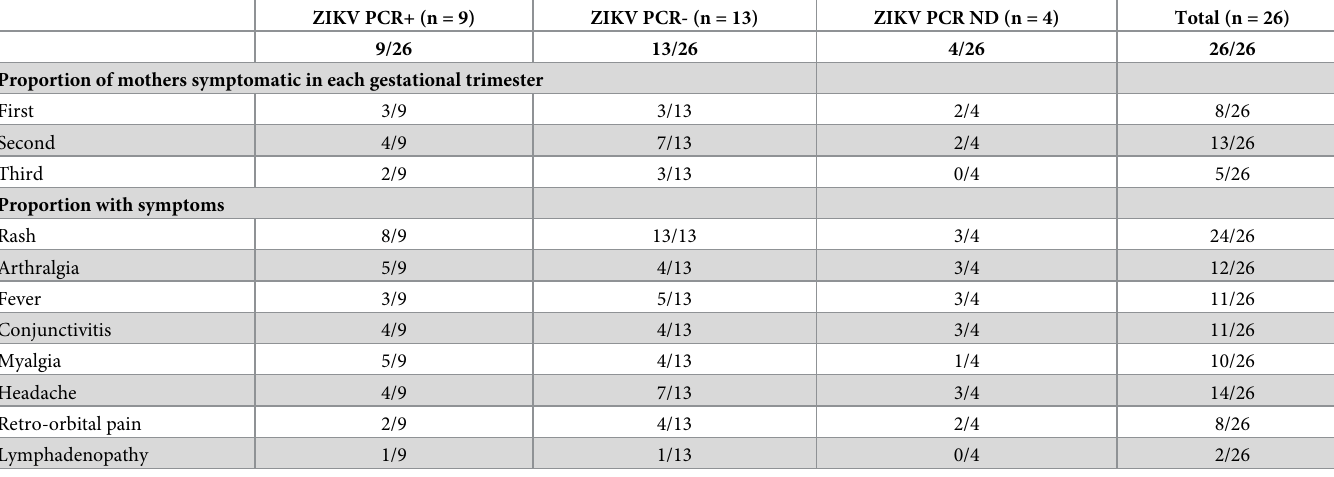
Table 1. Symptomatology of patient cohort at the time of enrollment based on ZIKV detection by